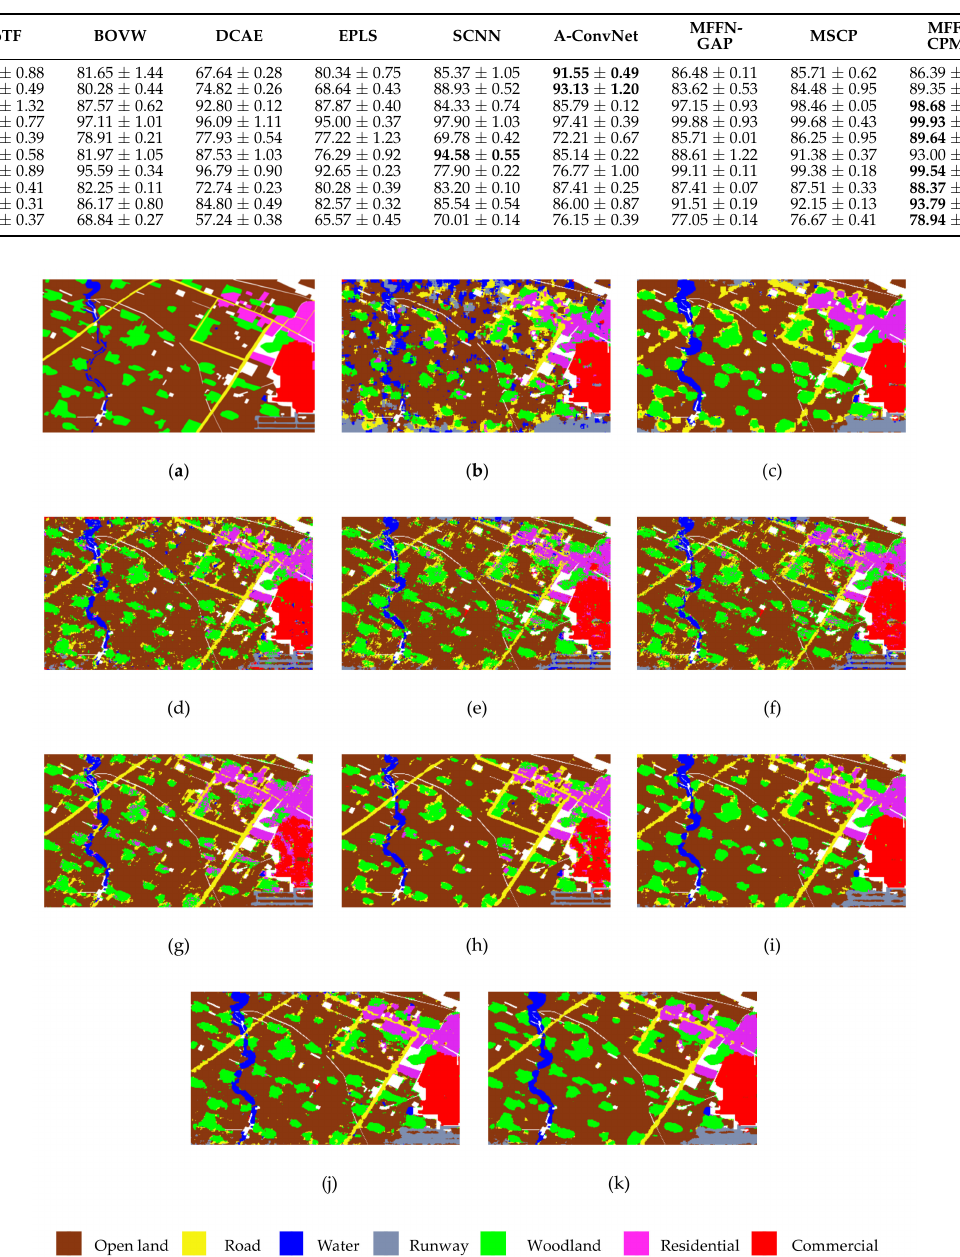
Table 7. Classification performance of airborne SAR image with different methods.